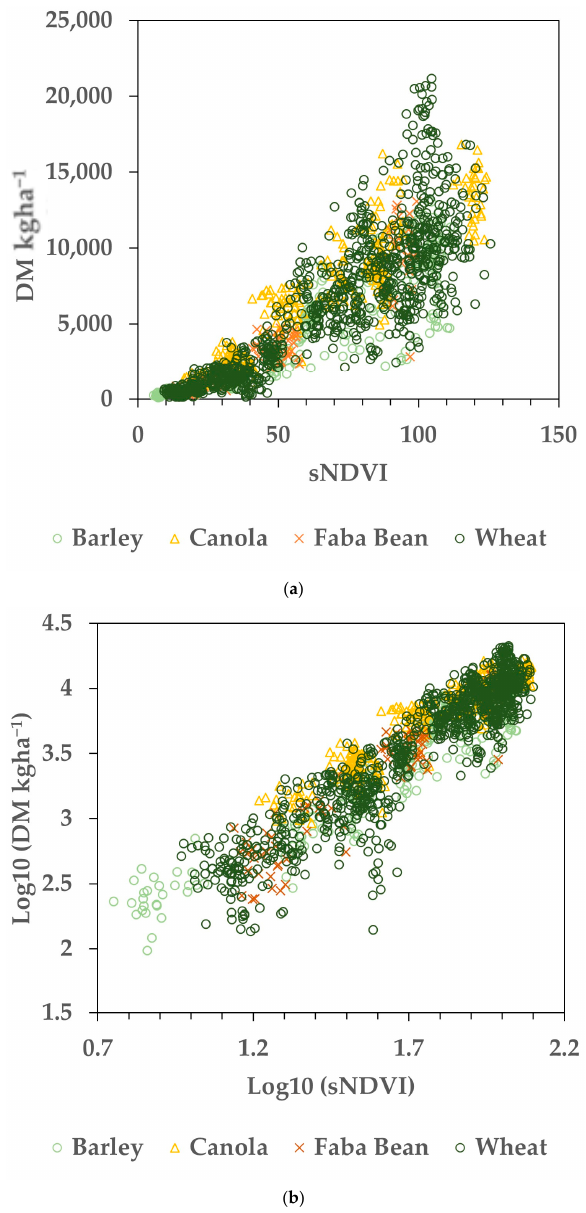
Figure 3. Calibration data representing 80% (N = 1664) of the Training dataset. ( a ) Data before log transformation. ( b ) Crop biomass and sNDVI data transformed with both using log10. Note that the remaining 20% of the dataset was used to evaluate the estimated versus measured biomass values.